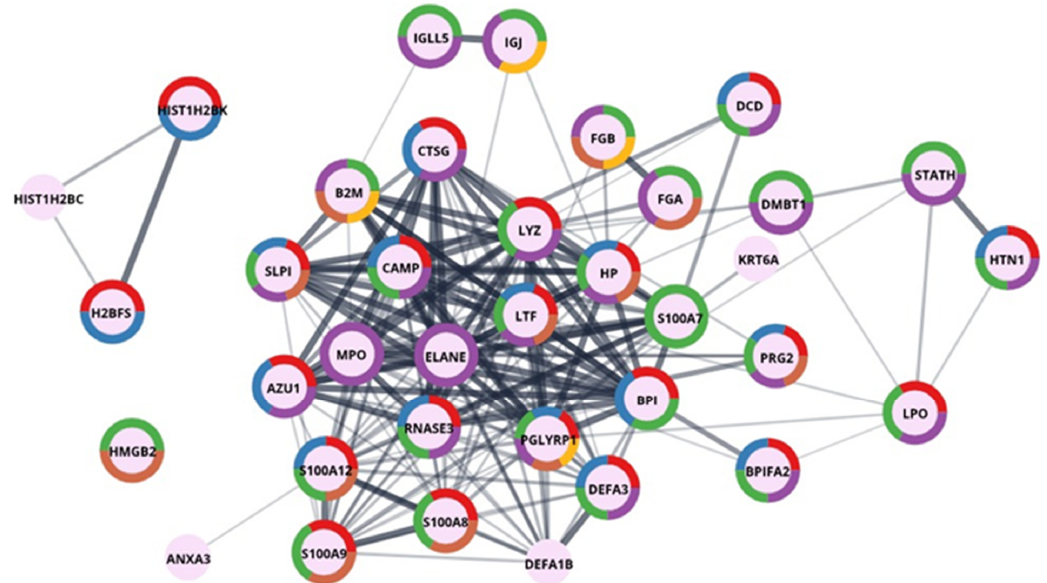
Figure 6. Graphic presentation of GO enrichment in the category—defence response to bacterium-associated proteins for sialolith1. The colours depicted in the circles correspond accordingly to protein function enrichment according to Uniprot keywords enrichment: red—antimicrobial, blue—antibiotic, green—secreted, purple—signal, brown—immunity, yellow—pyrrolidone carboxylic acid.